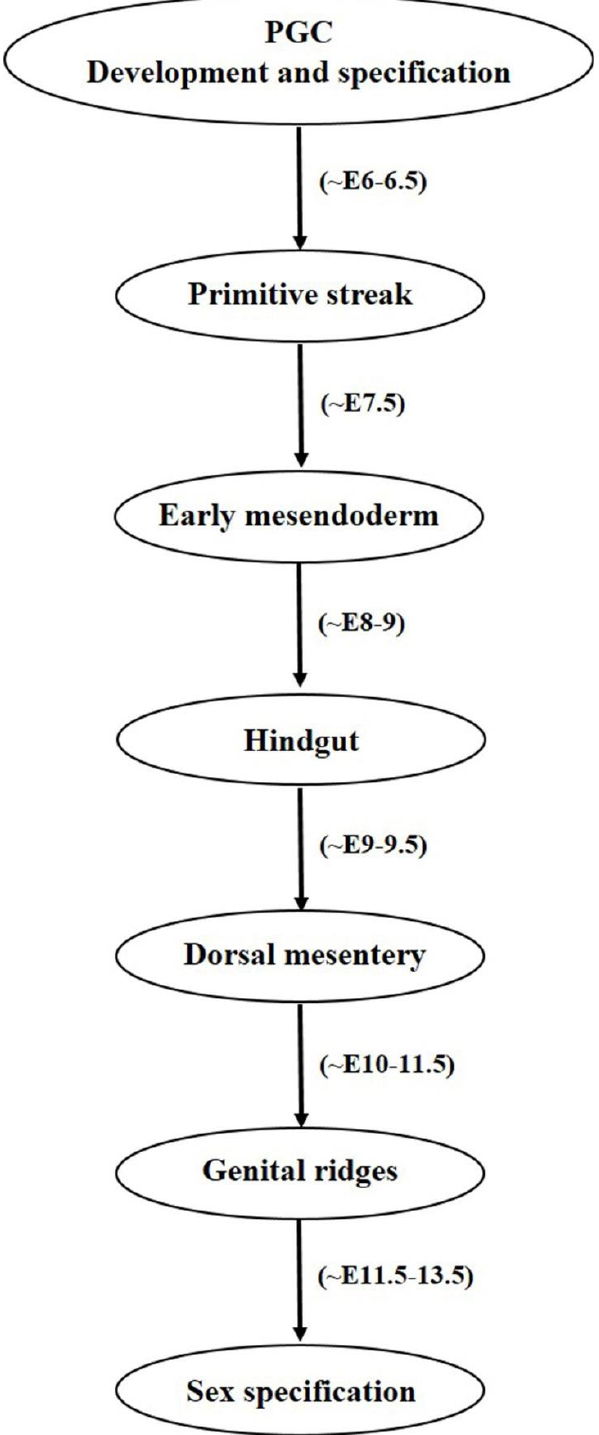
Figure 2. Diagrammatical outflow of the PGC migration. PGCs undergo a series of events before reaching gonadal ridges and finally sex specification. They are identified as a few precursor cells at the base of allantois and specified under the effect of molecular cues associated with Wnt3 and BMP pathways. After passing through a number of stages, PGCs finally enter genital ridges and specified as male and female gametes.